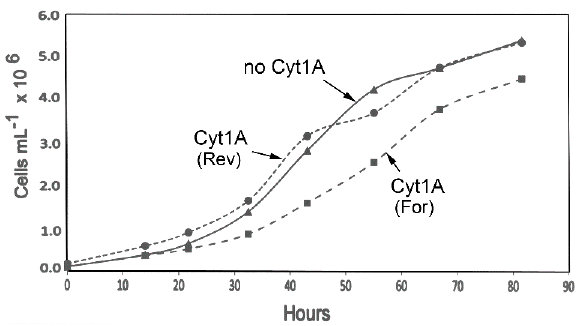
Figure 3. Growth curves for the cyt1Aa /CC-373 transformants. The indicated homoplasmic transformants were grown in 100-mL TAP cultures in 250-mL flasks as described in Methods. At the indicated times, aliquots (1 mL) were withdrawn, and total chlorophyll was quantified and converted to cell